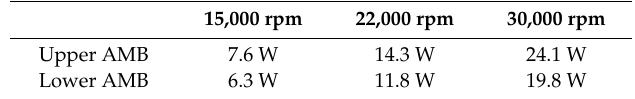
Table 1. Rotational losses in the radial